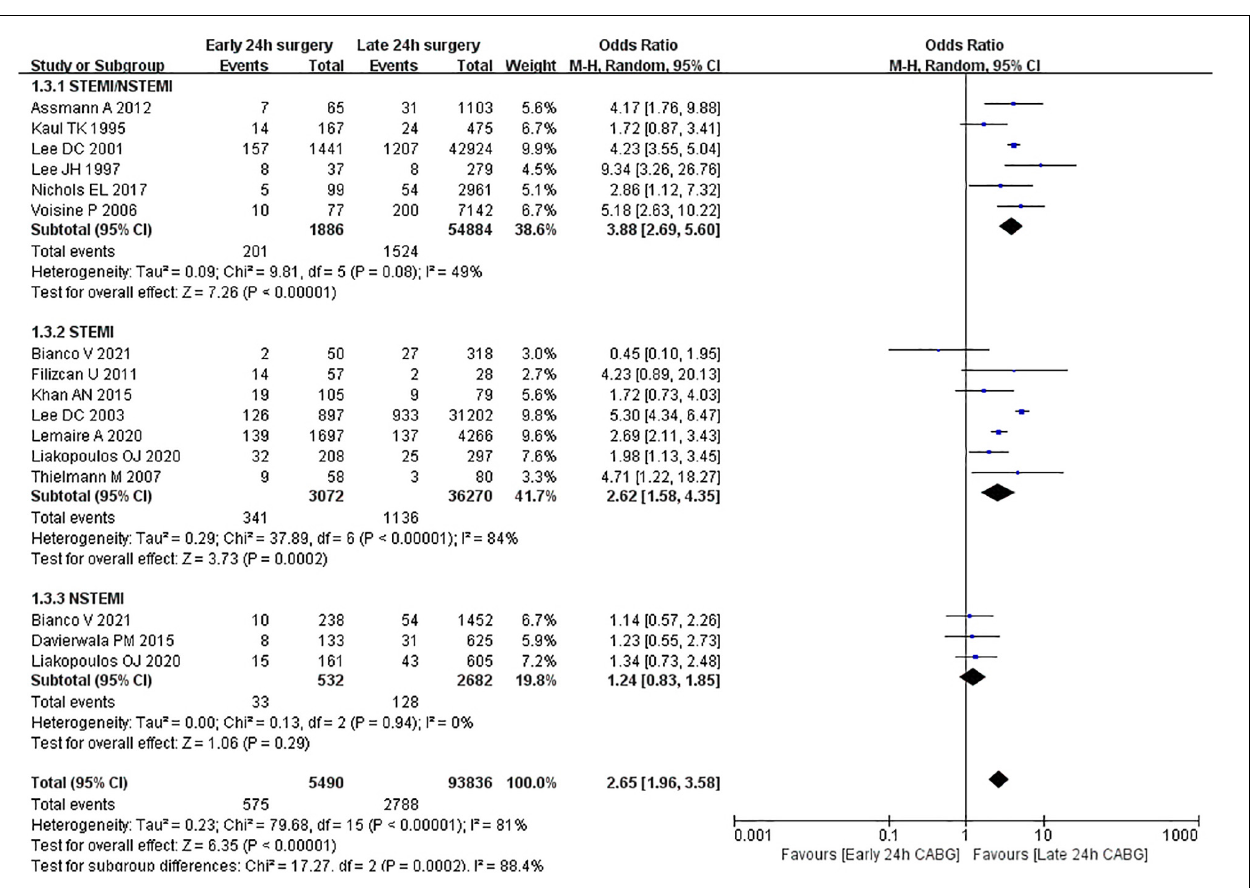
FIGURE 3 | In-hospital mortality in early 24 h CABG groups vs. late 24 h CABG